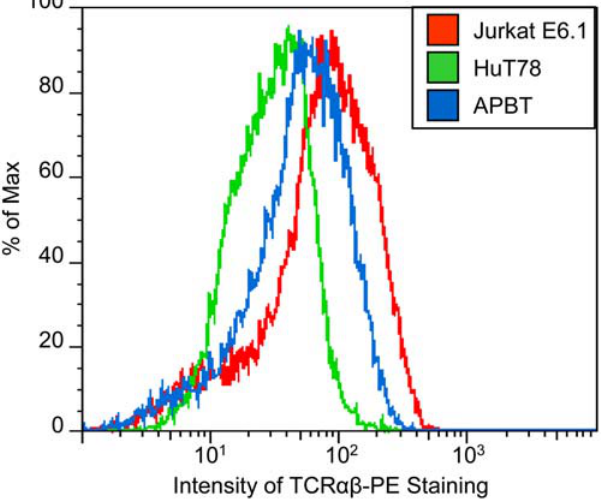
Figure 2. HuT78 T cells have less TCR surface expression than Jurkat E6.1 T cells and APBTs. The surface expression of the TCR a / b chain on Jurkat E6.1 T cells, HuT78 T cells, and APBTs was assessed by flow cytometry. A representative plot of the TCR surface expression of these cell lines is shown. The isotype control for each cell had a mean fluorescent intensity of , 8. The experiment was repeated three times.